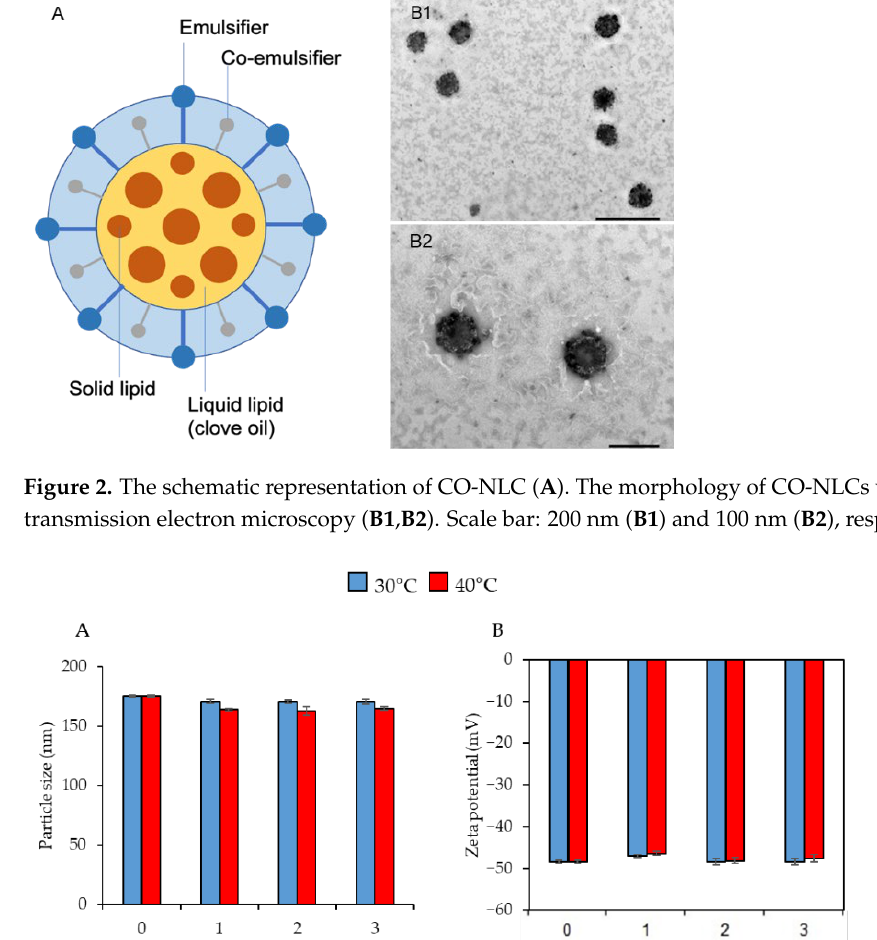
Figure 3. Particle size ( A ) and zeta potential ( B ) of CO-NLCs after storage at 30 ◦ C/60% RH and 40 ◦ C/75% RH for up to 3 months. No statistically significant difference of particle size and zeta potential ( p < 0.05) were found when stored at 30 ◦ C compared to 40 ◦ C. Data are expressed as mean ± standard deviation ( n = 3).